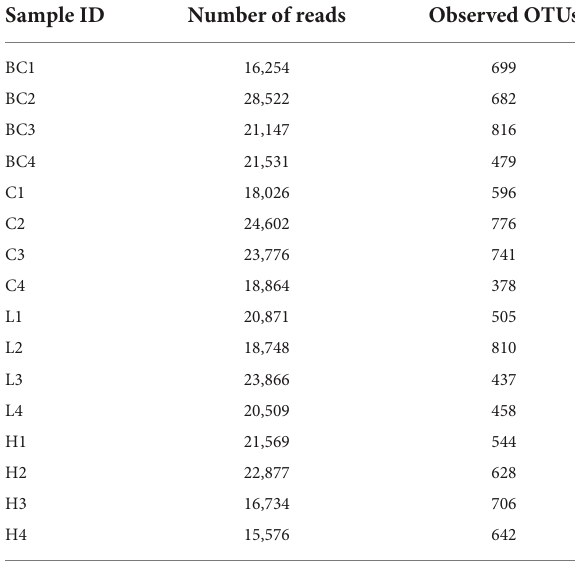
TABLE 1 Statistics of sequencing and OTUs of 16S rRNA in Group C, L, and